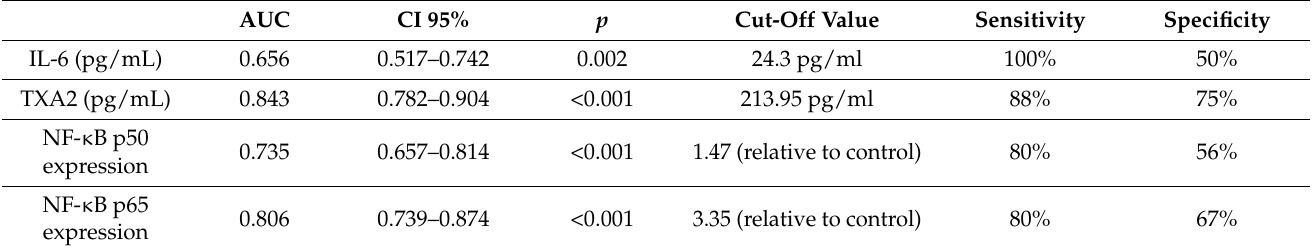
Table 6. AUC, sensitivity and specificity calculation for IL-6, TXA2, NF- κ B p50, and NF- κ B p65 in moderate group.